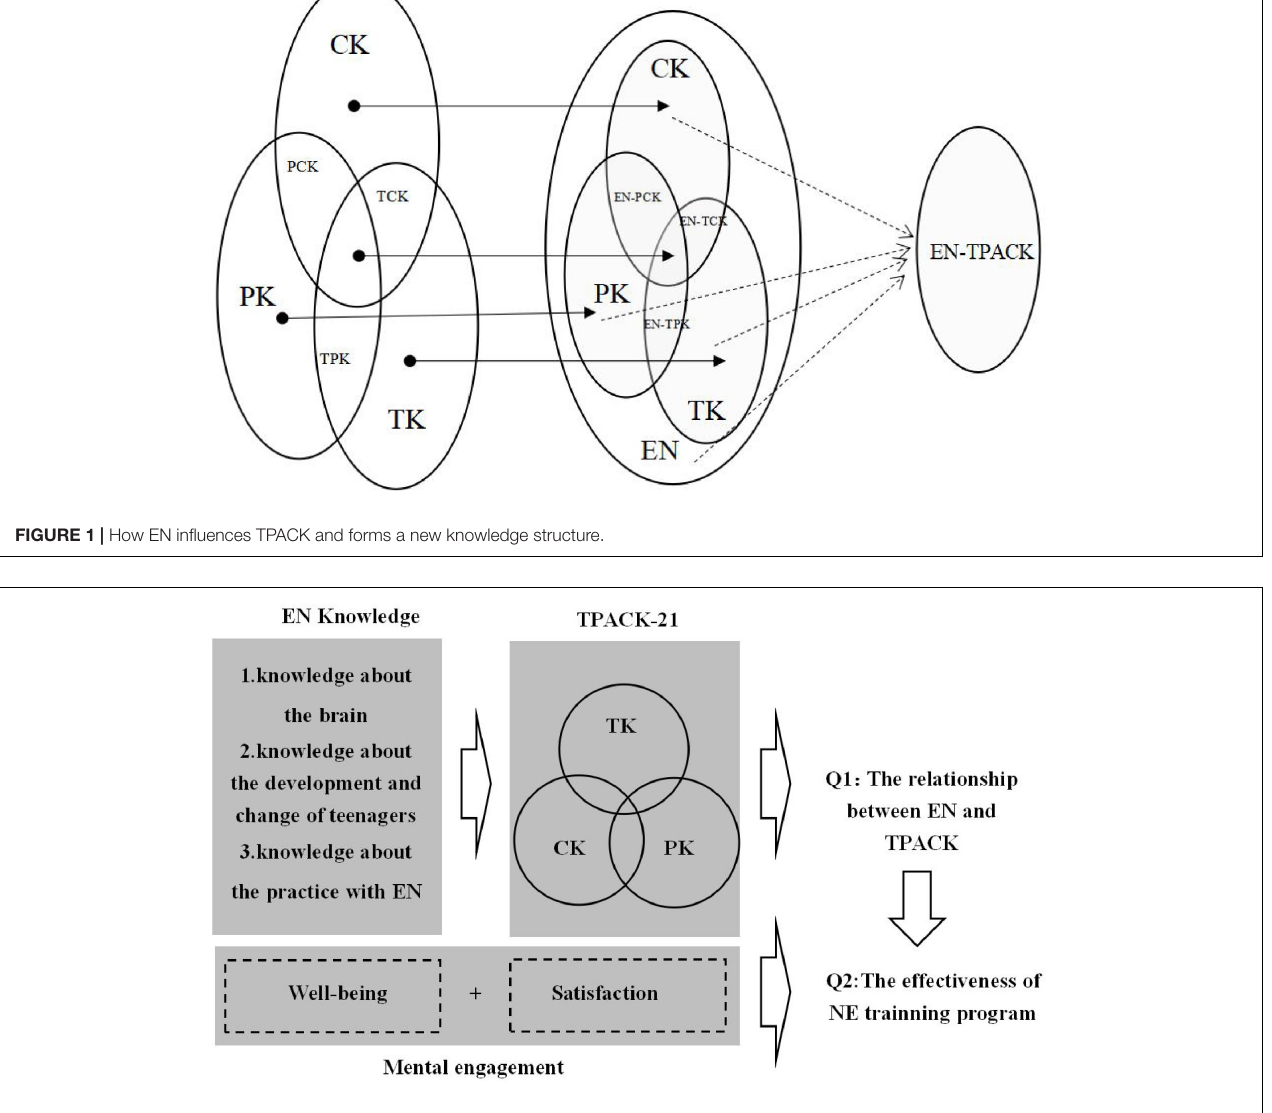
FIGURE 2 | The research